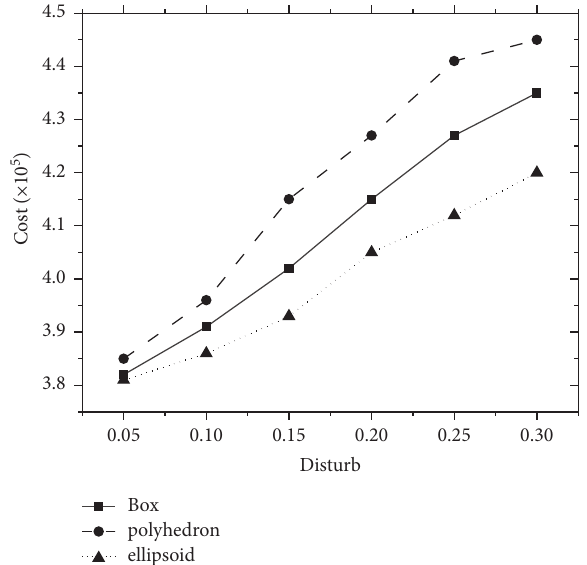
Figure 10: Impact of demand disturbance ratio on the